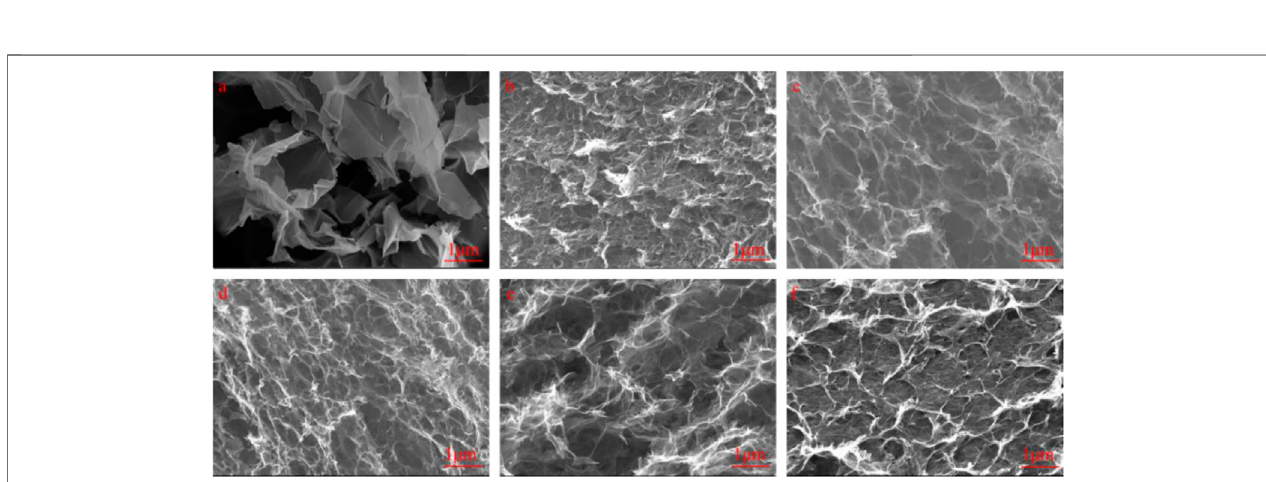
FIGURE 3 | (A) The speci fi c surface area histogram of the samples, (B) BET adsorption-desorption curve and pore size distribution (inset) for